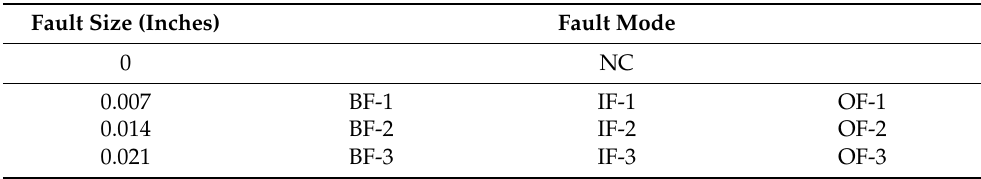
Table 2. CWRU bearing dataset faults classification.